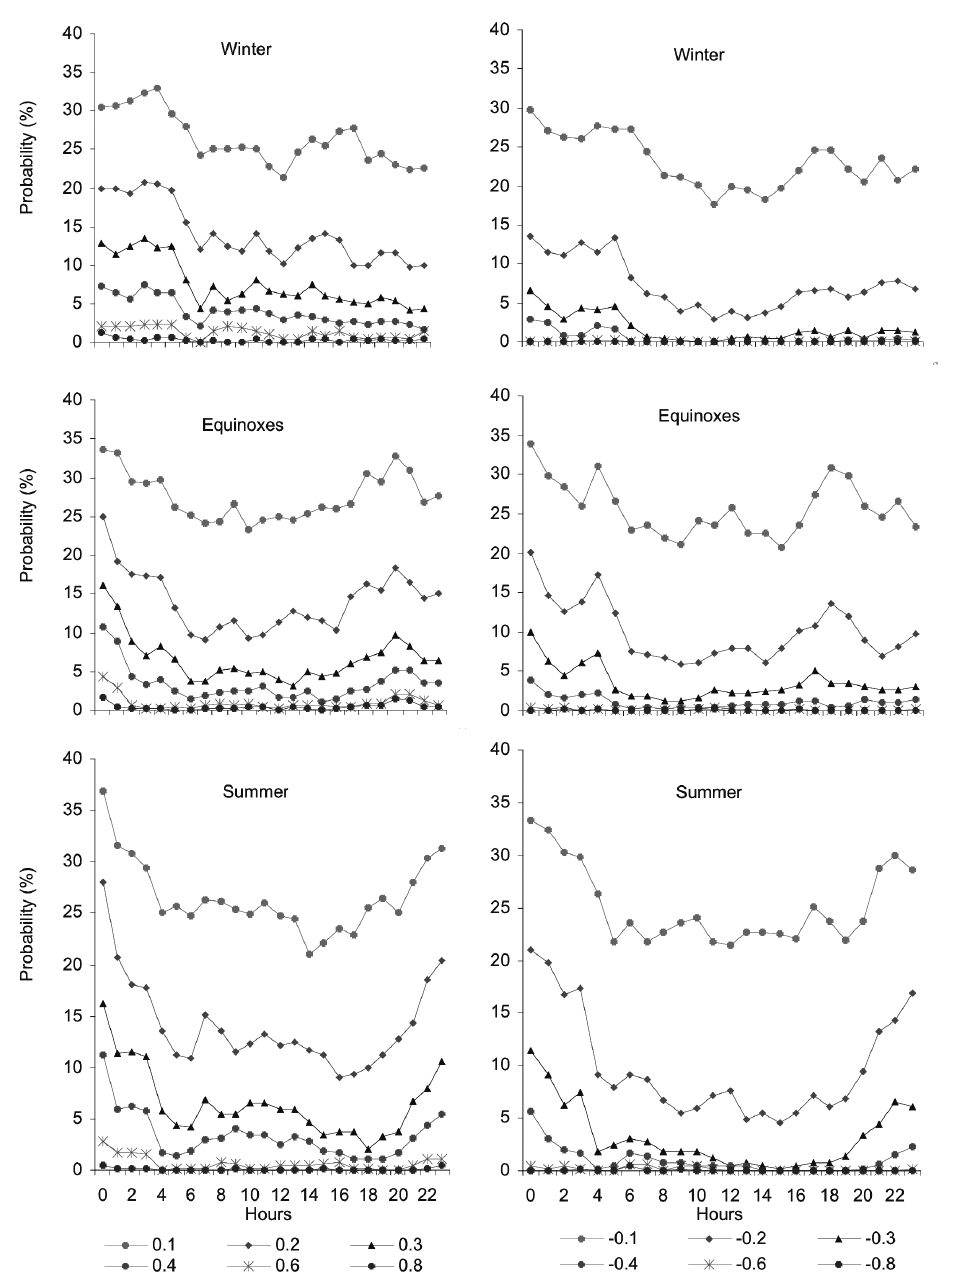
Fig. 9.3a. Probability that a given level, positive ( left ) or negative ( right ), of variability in TEC is exceeded at low solar activity